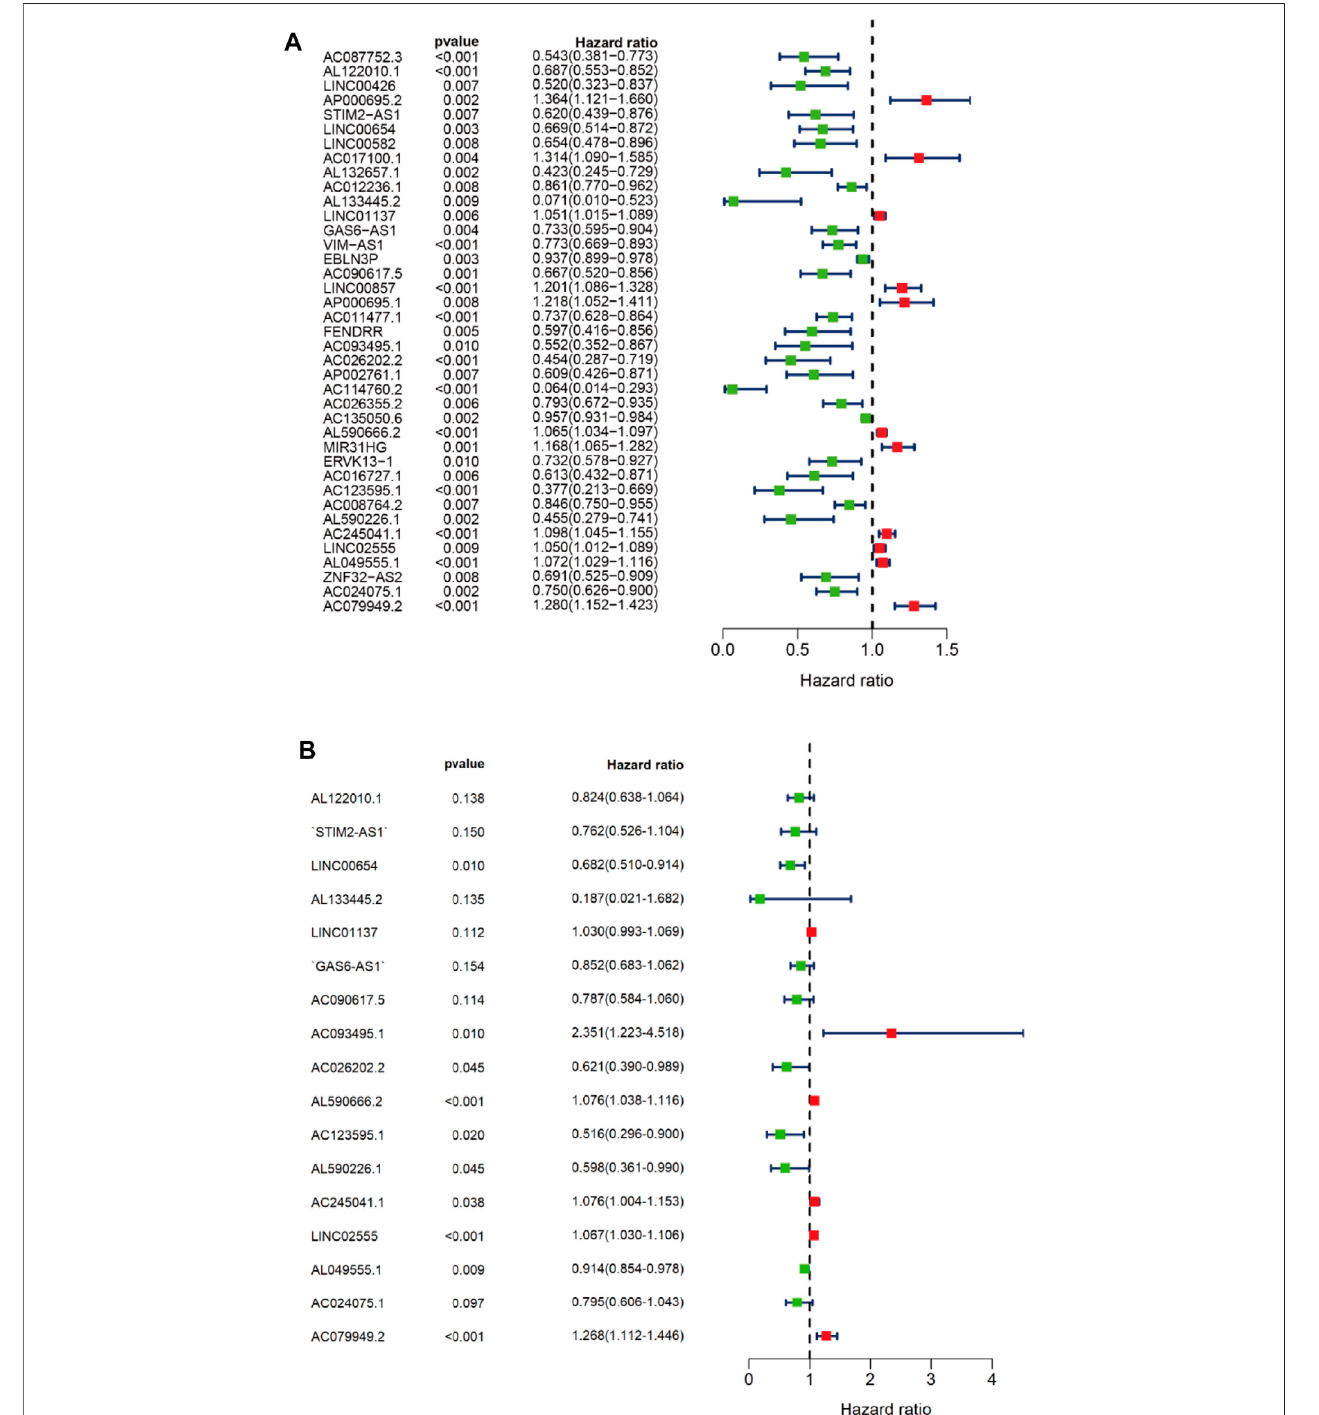
FIGURE7| UnivariateandmultivariateCoxregressionanalyses. (A) ForestmapofunivariateCoxregressionanalysis. (B) ForestmapofmultivariateCoxregression analysis. Red and green circles indicate high-risk and low-risk factors, respectively.